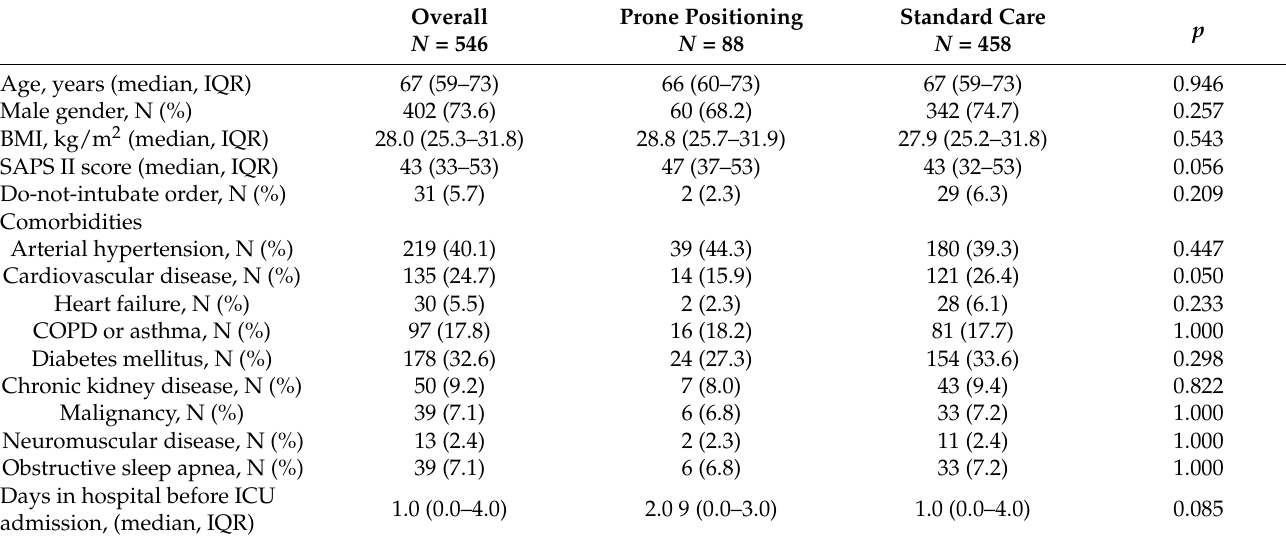
Table 1. Baseline characteristics.